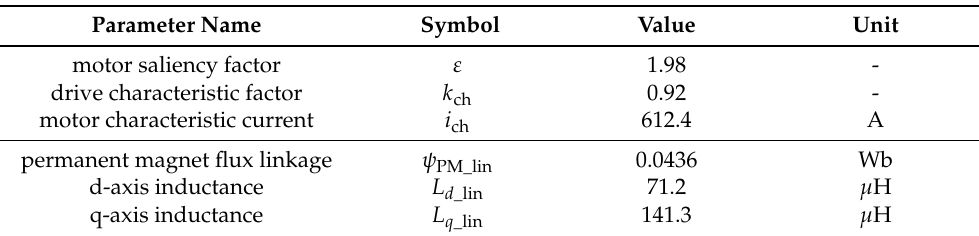
Table 2. The BMW i3 traction drive parameters obtained for the linearized model (3) for the current and voltage limitations listed in Table